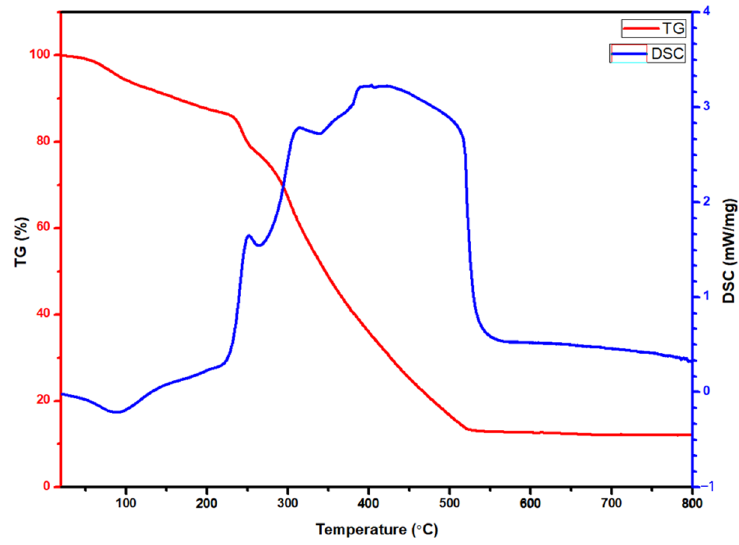
Figure 1. TGA/DSC curves of electrospun Cu 2 Y 2 O 5 nanofibers.